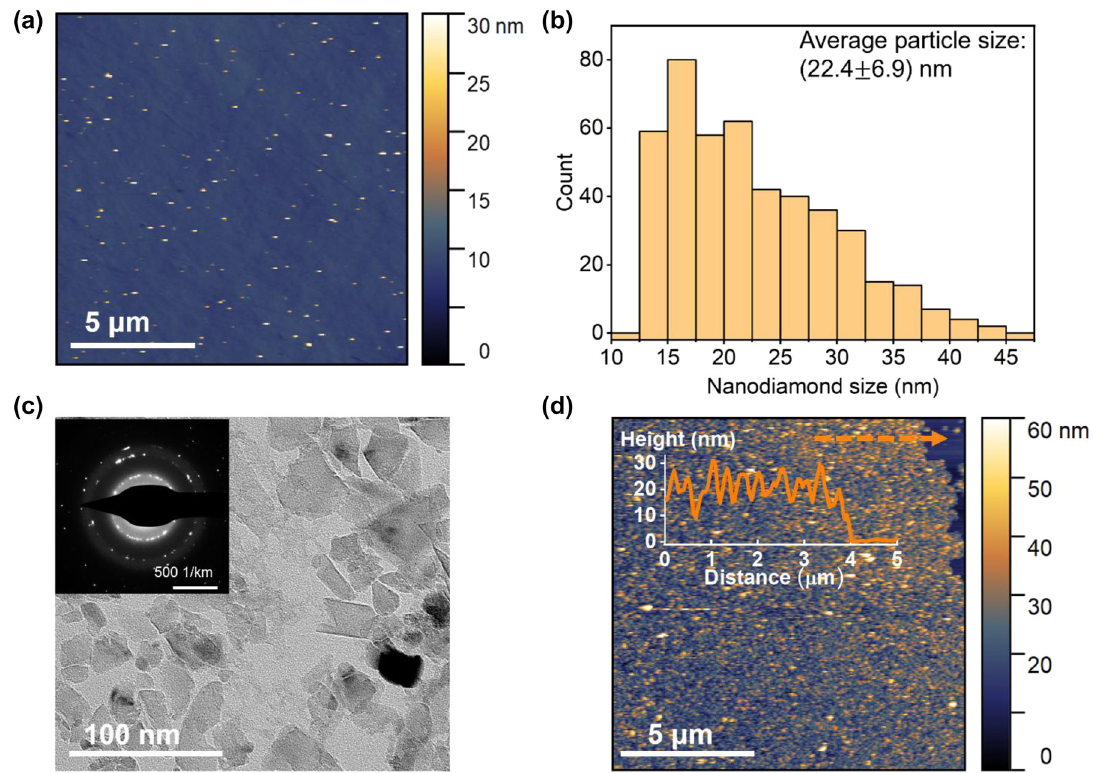
Figure 1: Characterization of non-fluorescent NDs prior to ion implantation. (a) AFM image of nanodiamonds drop casted from a suspension of 4 μ g/mL onto a quartz coverslip. (b) Histogram showing the ND size distribution. Sizes are collected from 449 isolated NDs in AFM scans. Particles with heights < 12 nm are excluded from the statistics as they could be dirt or features on the substrates. (c) Bright-field TEM image of a cluster of NDs. Inset: electron diffraction pattern taken over the entire area. (d) AFM image of NDs on a quartz coverslip for ion implantation experiments. The sample is drop casted from a suspension of 400 μ g/mL. Inset: a height profile along the dashed orange line, illustrating a ND layer thickness of ∼ 20 nm that is comparable to the average height/size of NDs.